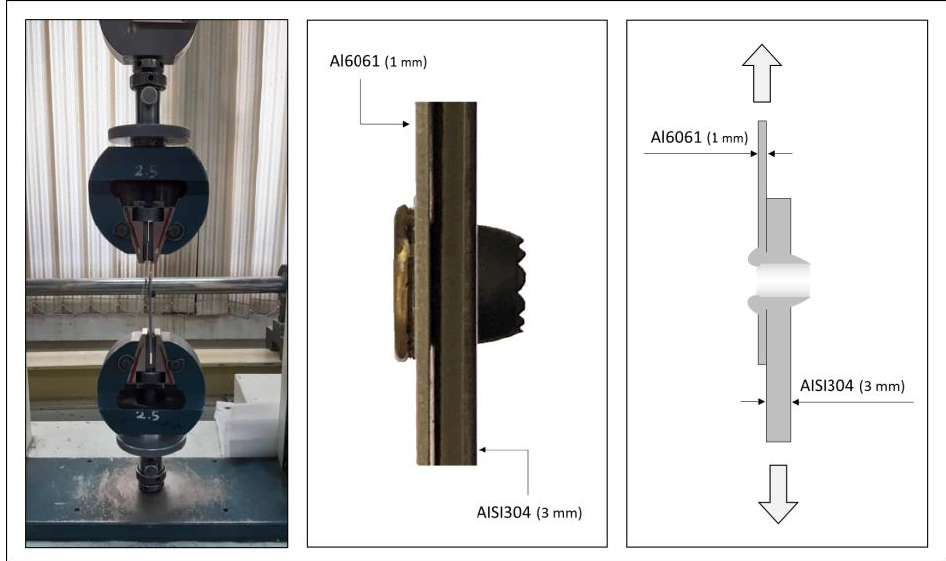
Figure 7. Experimental and schematic illustration of the tensile-shear strength test.